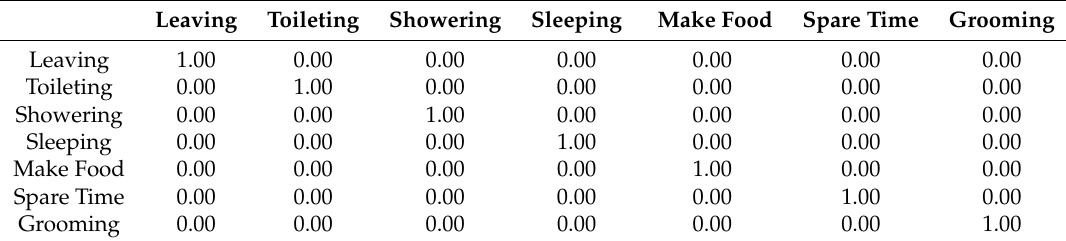
Table 9. Jaccard similarity indices for context descriptors for Ordonez House